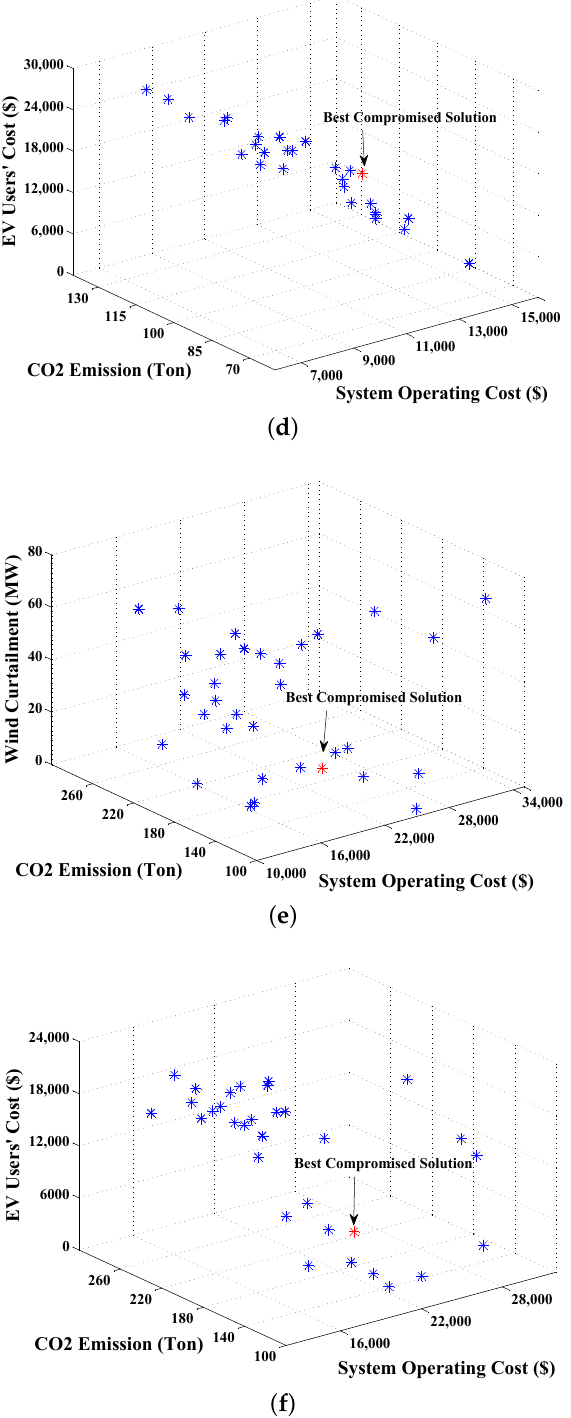
Figure 5. Result of the multi-objective problem (MOP) of four different scenarios. ( a ) Pareto front at 18:00; ( b ) Pareto front at 18:00; ( c ) Pareto front at 4:00; ( d ) Pareto front at 4:00; ( e ) Pareto front at 1:00; and ( f ) Pareto front at